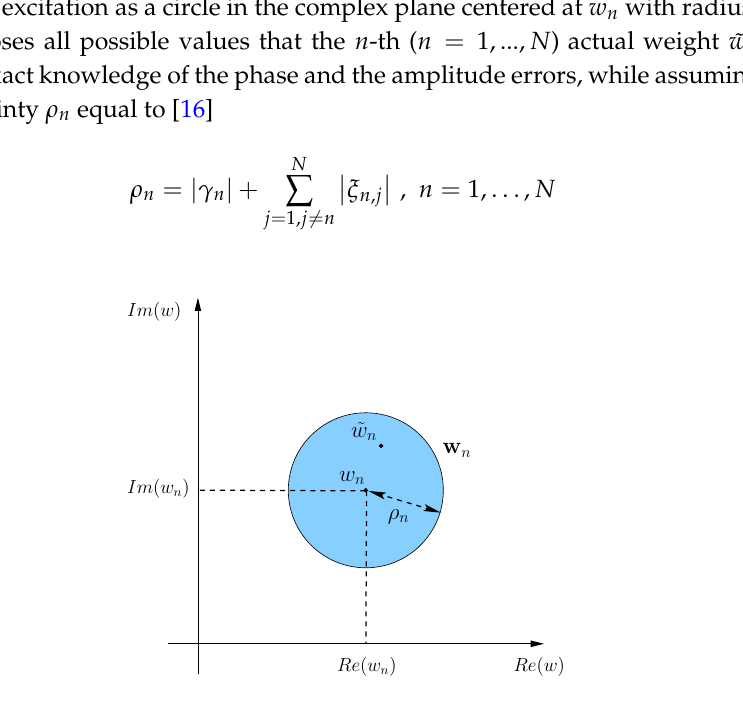
Figure 1. Interval Analysis (IA)-based approach—complex circular